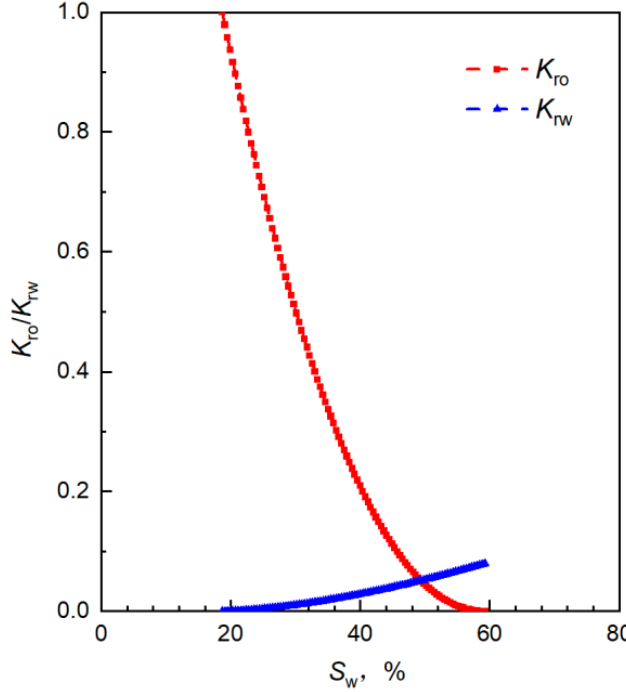
Figure 5. The oil – water relative permeability curve. Figure 5. The oil-water relative permeability curve. Table 2. Relevant parameters of the oil-water relative permeability curve. S wi S